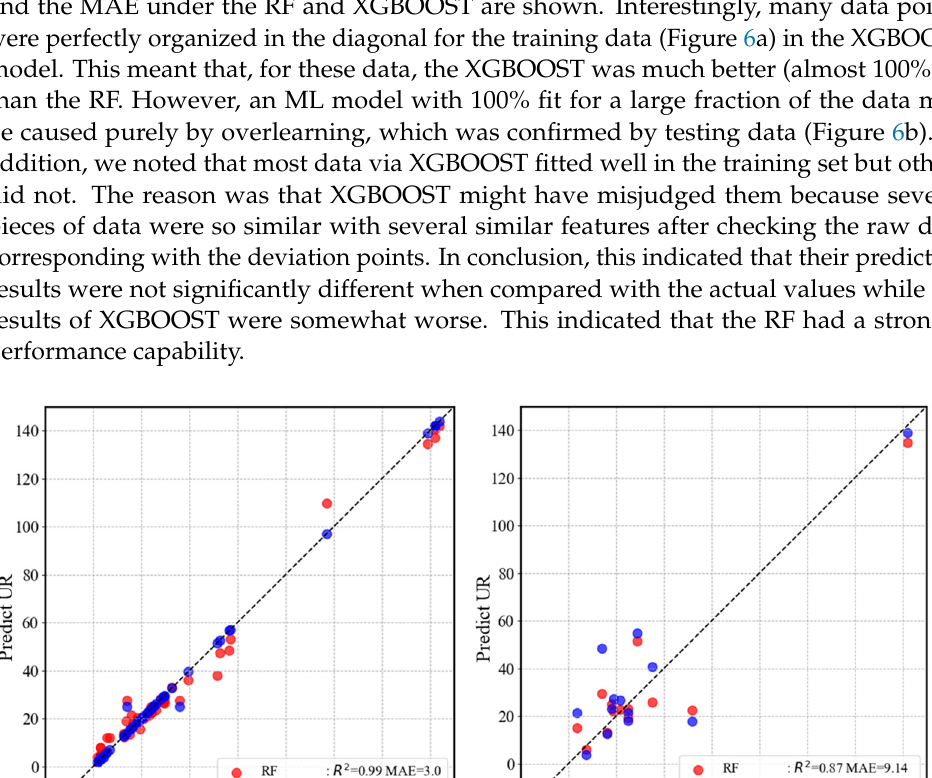
Figure 7. Ranking the importance of features . In Figure 8, the degree to which the selection of features affected the RF model is shown. It demonstrated that 2–6 combinations of features from high to low (according to Figure 4) were required to predict the undercooling by taking the average value after 100 training sessions. With an increase in the number of features, R 2 demonstrated a slight